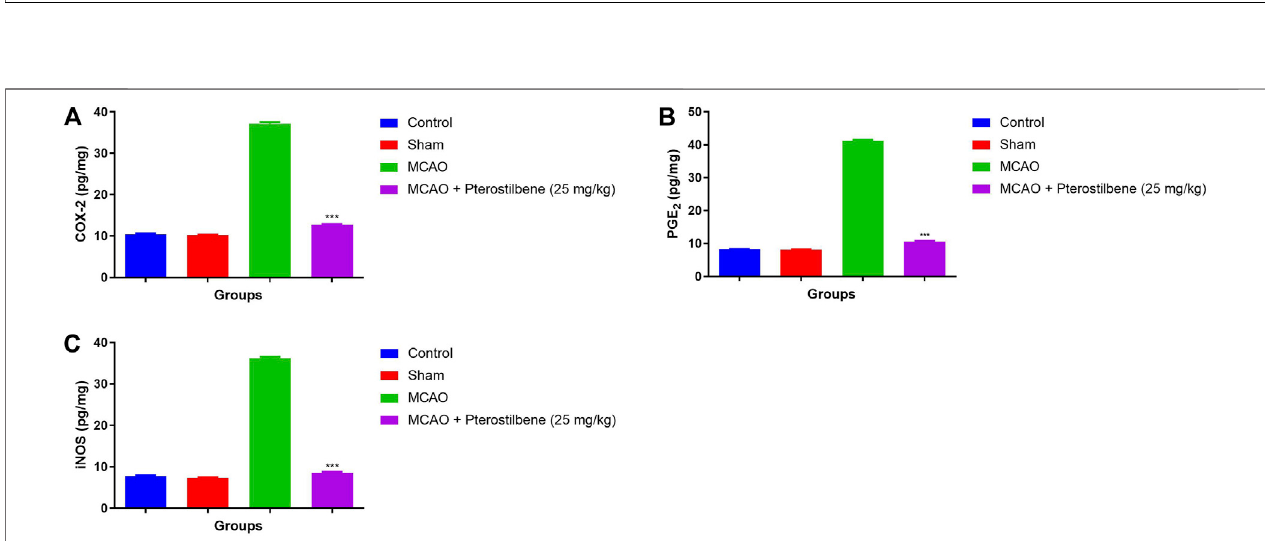
FIGURE 11 | showed the in fl ammatory mediators of among experimental groups. (A) COX-2, (B) PGE 2 and (C) iNOS. Values are expressed as mean ± SEM. The t -test was used for the signi fi cant difference between groups: * p < 0.05, ** p < 0.01, *** p < 0.005. NS, non-signi fi cant.